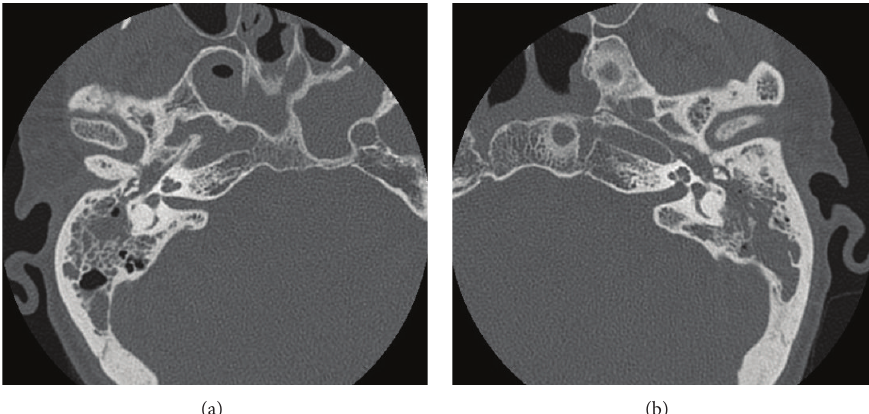
Figure 3: CT scan showing inflammatory tissue filling both left and right tympanic